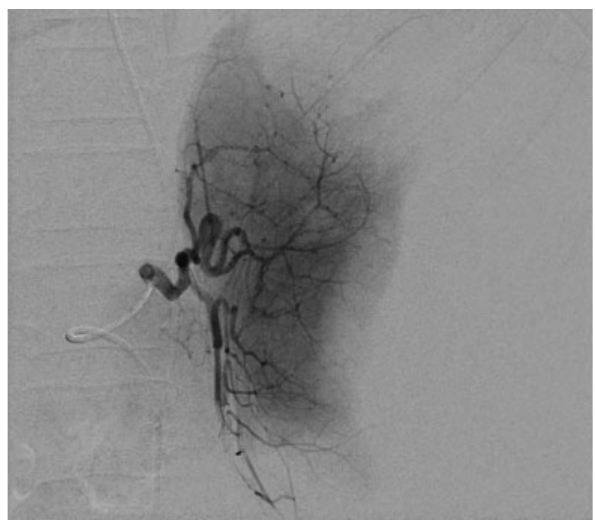
Fig. 2 Digitally subtracted image from the splenic artery angiogram, showing distortion of the splenic anatomy by the hematoma, loss of parenchymalperfusioninthelateralpartofthespleenandmultipleareasof